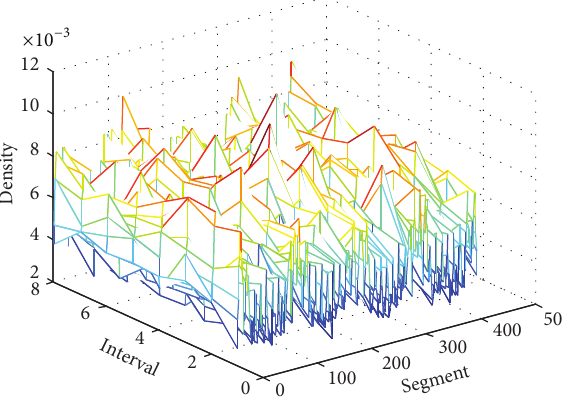
Figure 8: Density on each segment per interval when demand is 5.